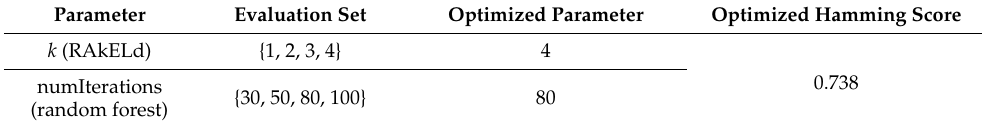
Table 4. Model parameters selection and optimized performance for the MTC model.